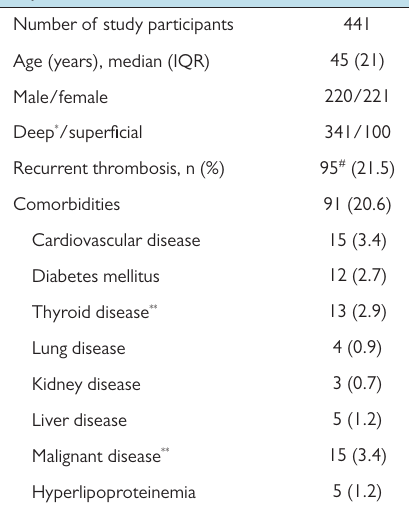
Table 1. Characteristics of the Study